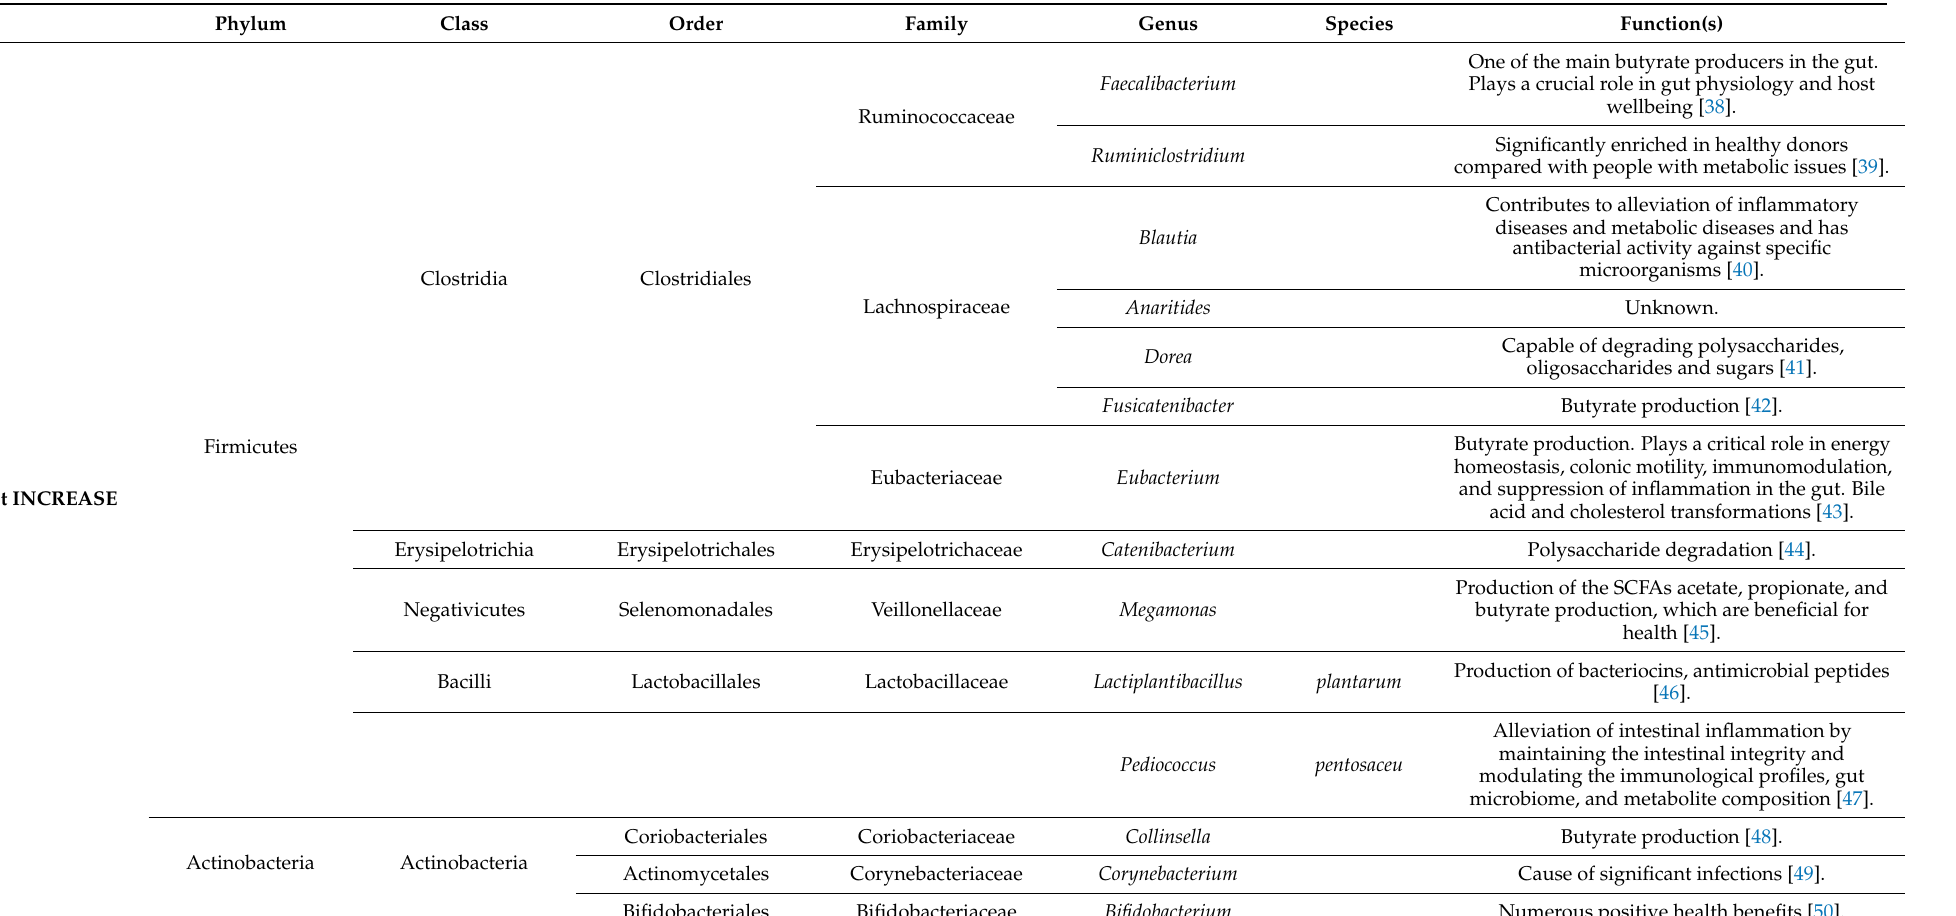
Table 4. Bacteria whose relative abundance is modified by the interventions described in this review and their functions in health and